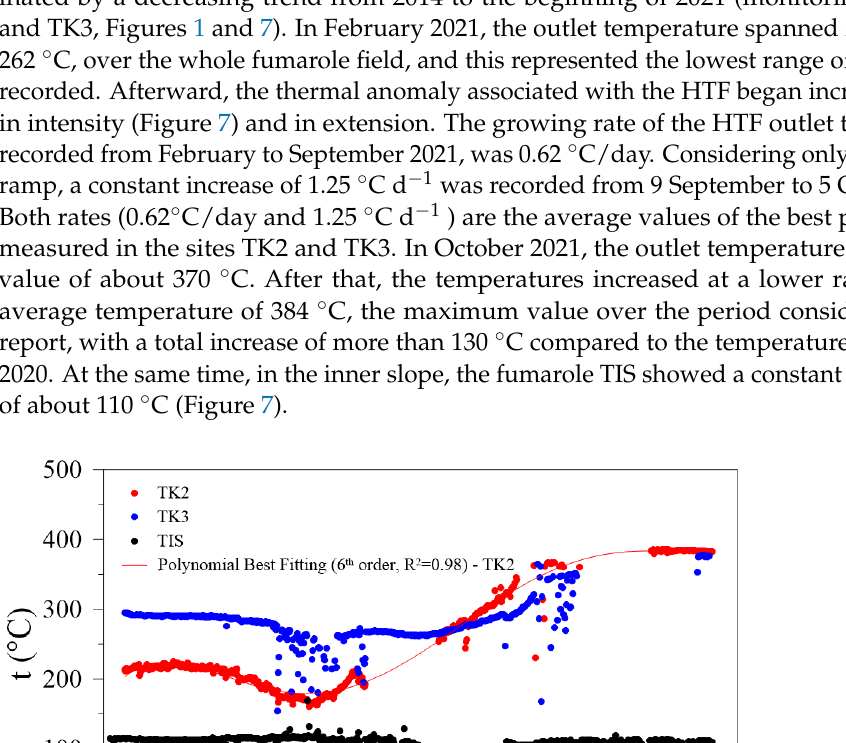
Figure 6. Monthly and daily bulk SO 2 flux measured in the crater plume between June 2020 and July 2021, and from September 2021 to April 2022, respectively. The red line is a 7-day moving average on the daily SO 2 flux.